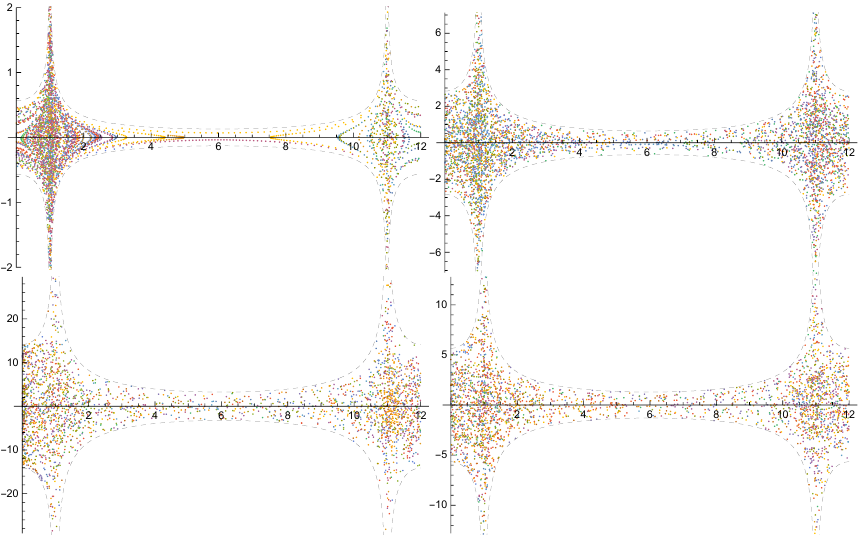
Figure 8 . (cid:17) (cid:0) P (cid:17) plane projections of the Poincare section at (cid:31) = 0 for the Uluru spacetime. Clockwise from top left E = f 0 : 1 ; 0 : 5 ; 1 ; 2 : 5 g . The plots (cid:12)ll an area bounded by maximal value of P (cid:17) compatible with the constraint that H = 0 indicated with a grey dashed line. The 100 di(cid:11)erent seed initial conditions that are numerically evolved to generate these sections are indicated by colour. For small values of E we have a perturbation around an integrable Hamiltonian and one sees vestiges of KAM tori which as E is increased dissolve away.